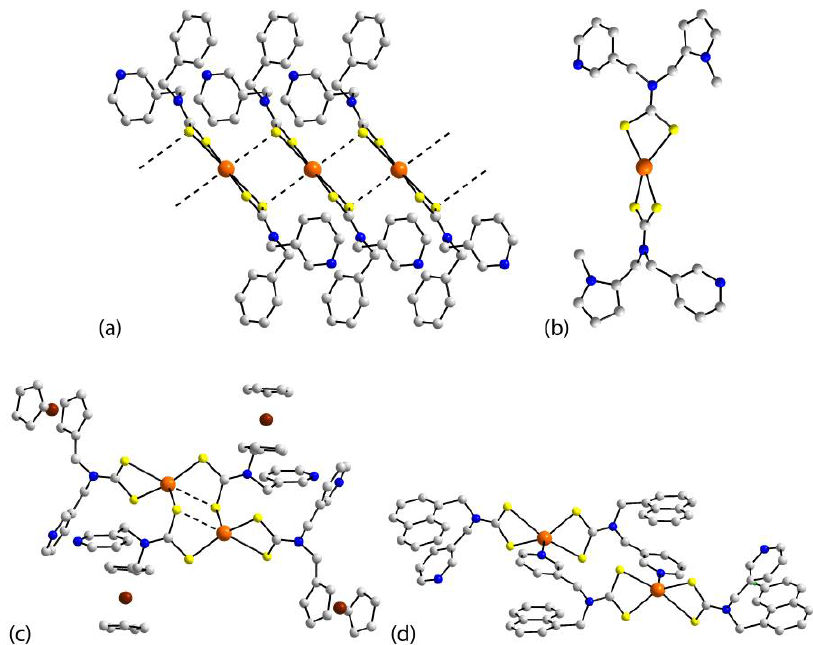
Figure 12. ( a ) The supramolecular chain in Hg(L 1 ) 2 ( 36 ) mediated by Hg · · · S interactions, ( b ) the tetrahedral molecule in Hg(L 17 ) 2 ( 38 ), ( c ) the di-nuclear molecule in [Hg(L 13 ) 2 ] 2 ( 40 ), and ( d ) the di-nuclear molecule in [Hg(L 19 ) 2 ] 2 ( 41 ).